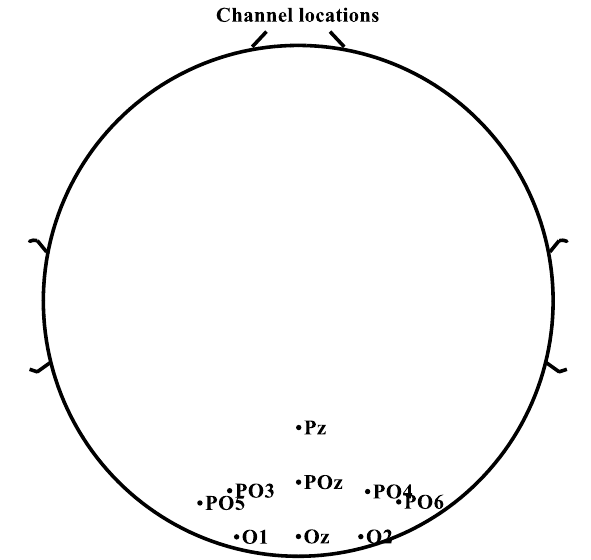
Figure 5. Channel